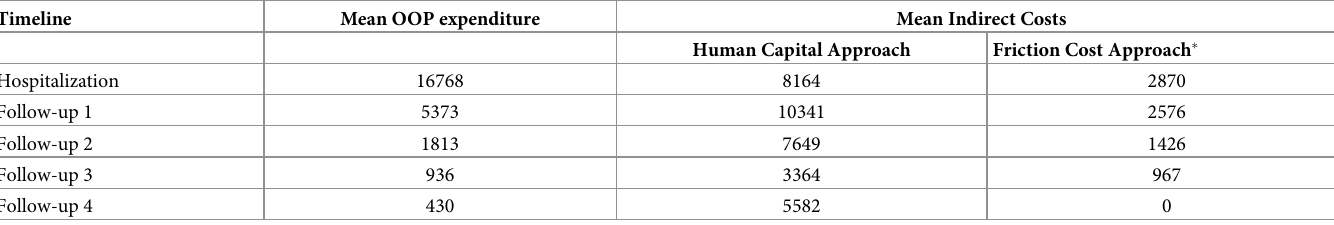
Table 4. Mean OOP expenditure and mean Indirect costs due to injury-related